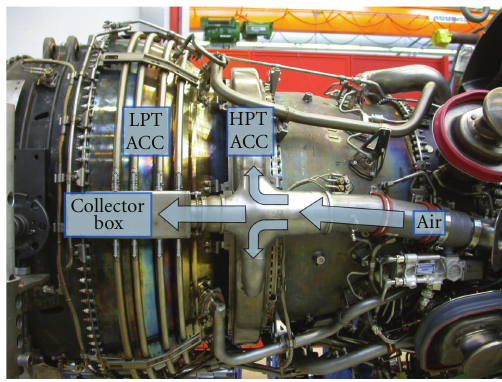
Figure 1: ACC system, Ahmed et al. [5].